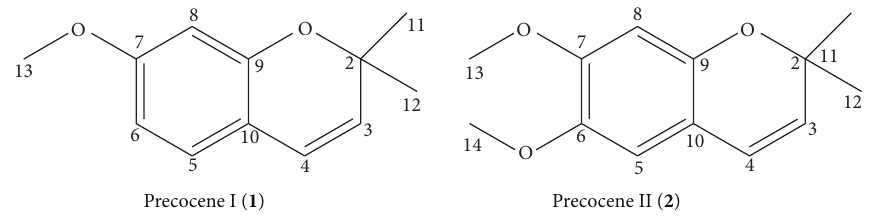
Figure 1: Precocenes isolated from Ageratum houstonianum essential